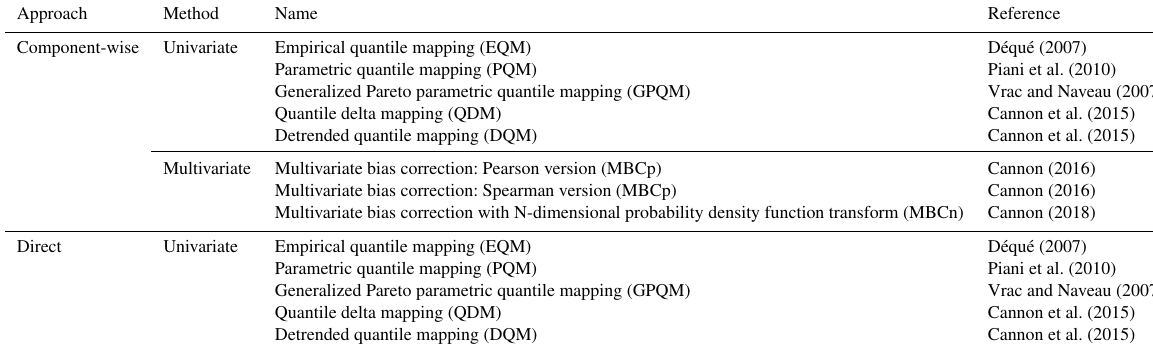
Table 3. Bias correction approaches and methods employed in the present